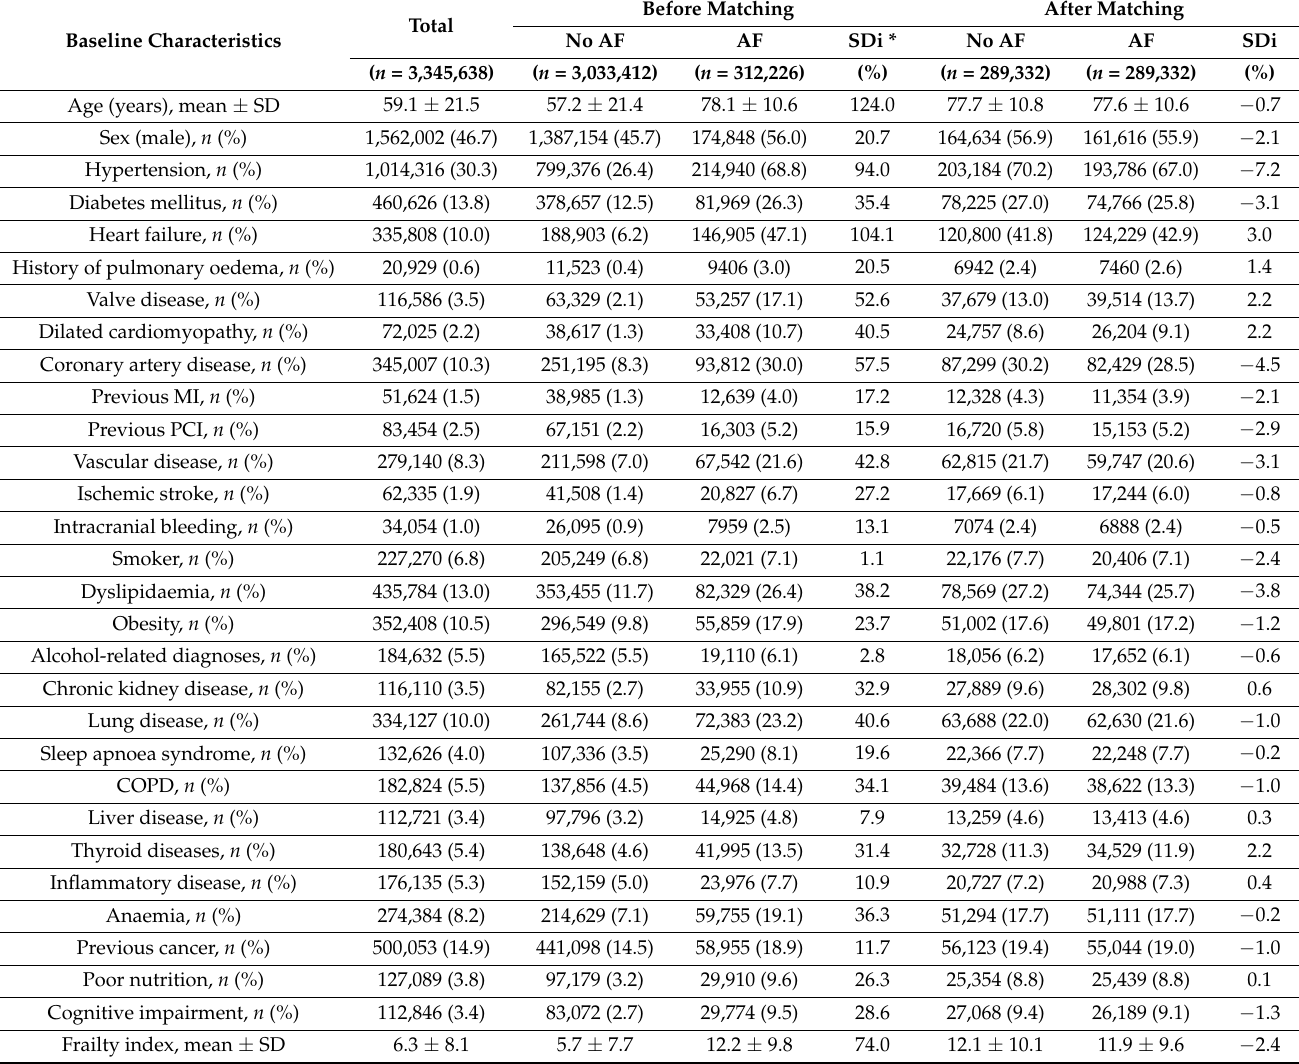
Table 1. Baseline characteristics of the French hospitalised patients with and without